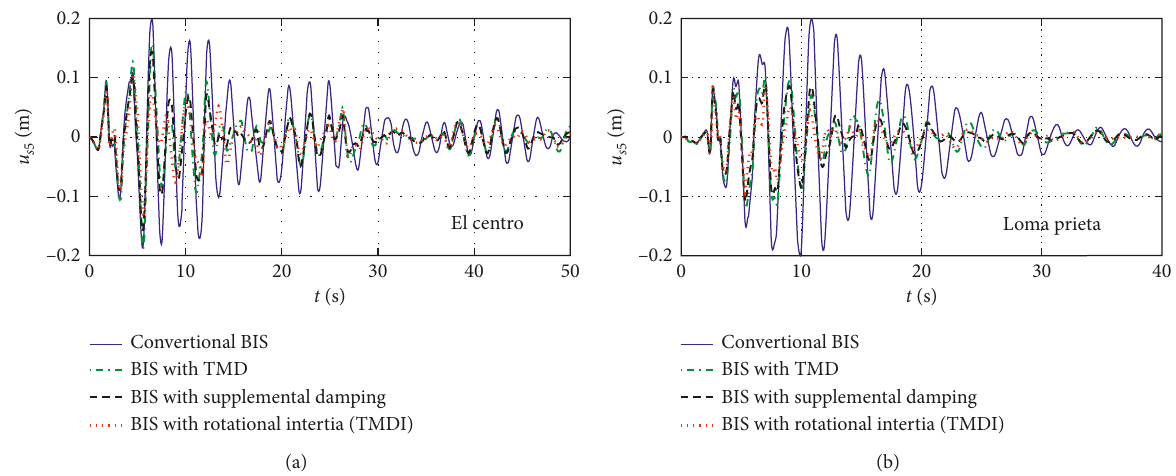
Figure 18: Last-floor displacement time-history response of the RC building shown in Figure 14 subject to El Centro (a) and Loma Prieta (b) earthquake ground